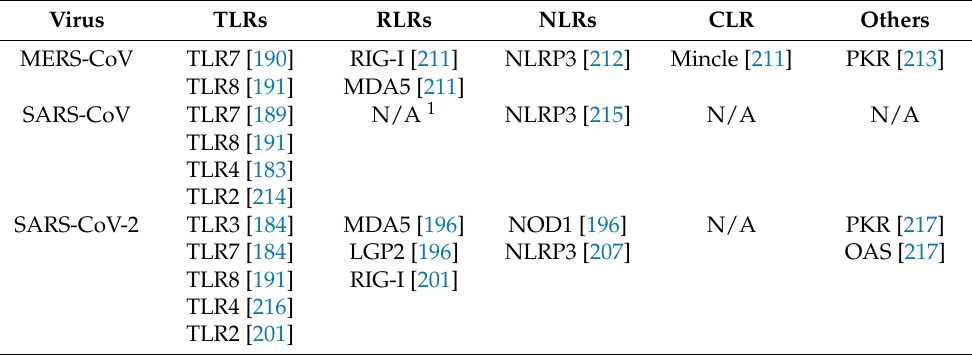
Table 2. The comparison of innate immune sensors involved in recognition of MERS-CoV, SARS-CoV, and SARS-CoV-2 infections.